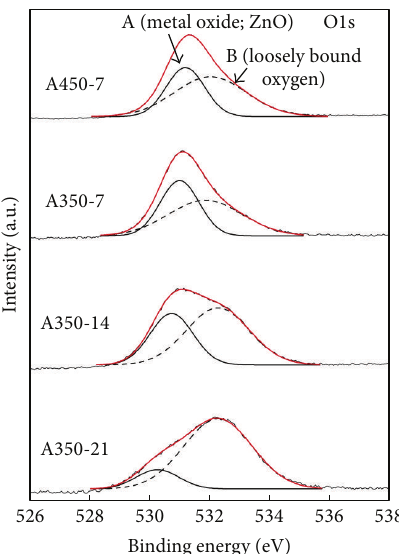
Figure 4: XPS O1s spectra of the AZO films.